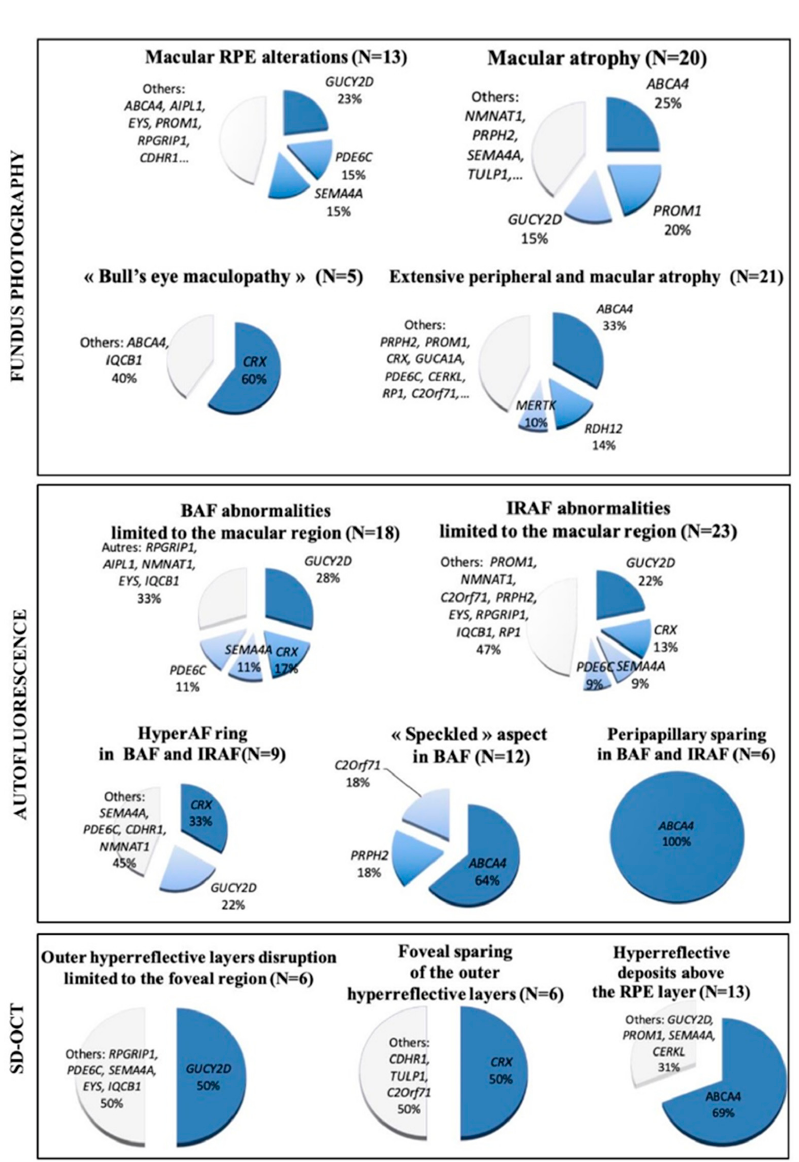
Figure 4. Profile of mutated genes for each feature observed on retinophotography, fundus autofluorescence, and spectral domain OCT.